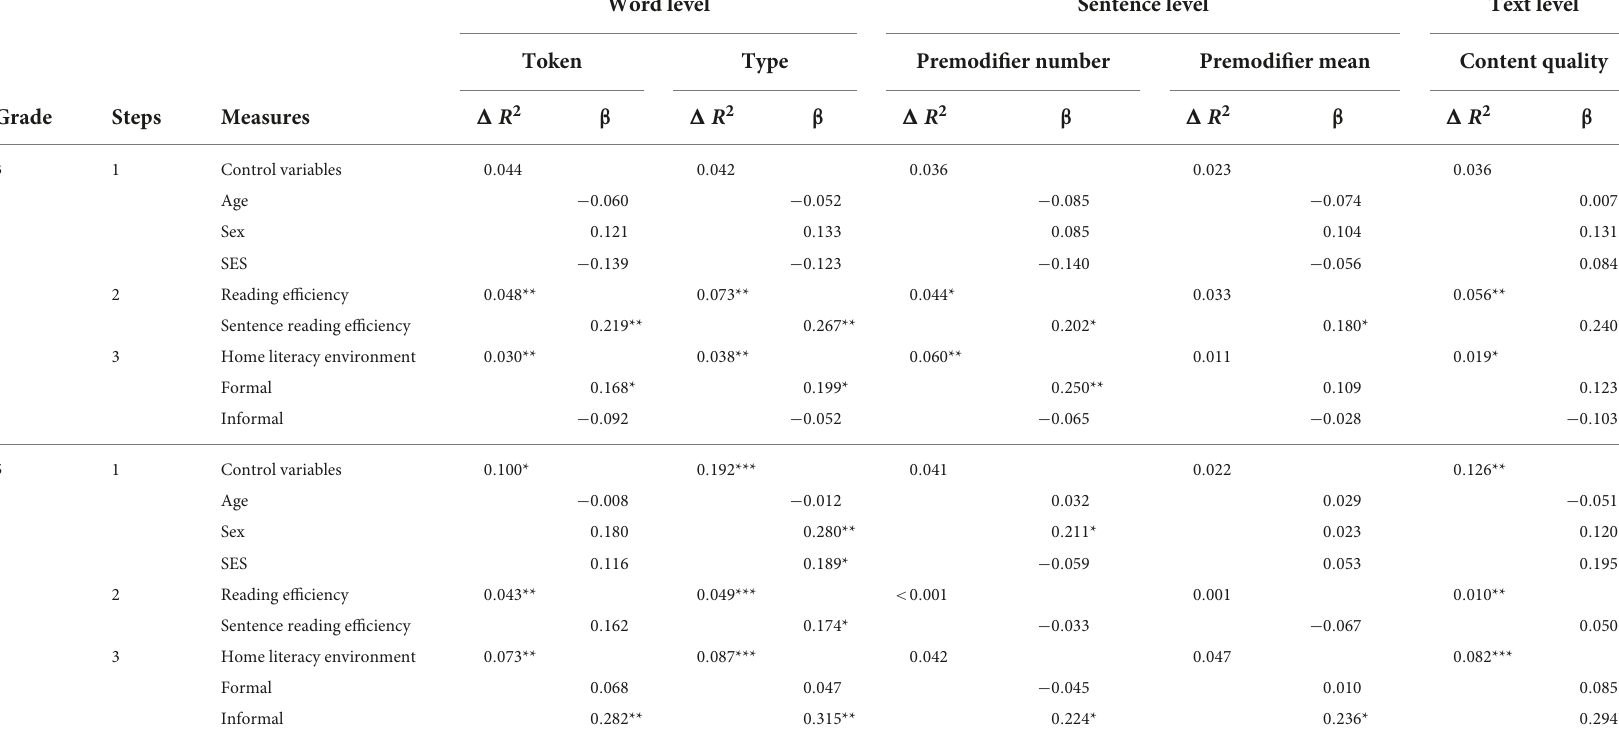
TABLE 4 Hierarchical regression analyses of writing measures using reading efficiency and home literacy environment (HLE) as